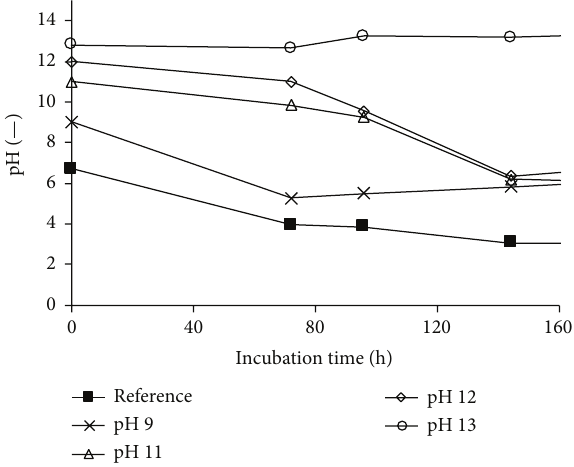
Figure 10: Evolution of pH during the growth of Aspergillus niger in potato dextrose broth medium with different initial pH